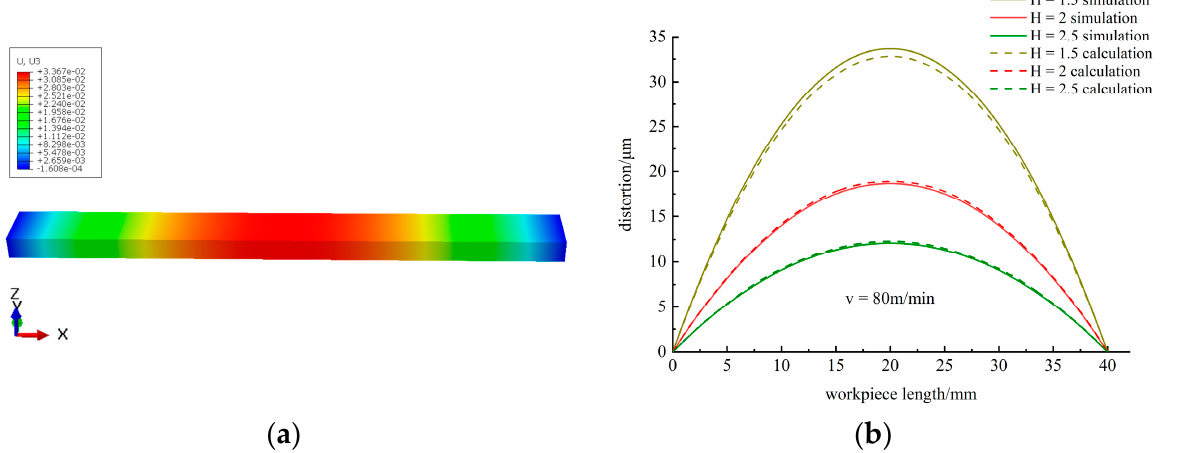
Figure 8. Influence of workpiece thickness on distortion. ( a ) results of workpiece distortion simulation; ( b ) simulation and calculation results.